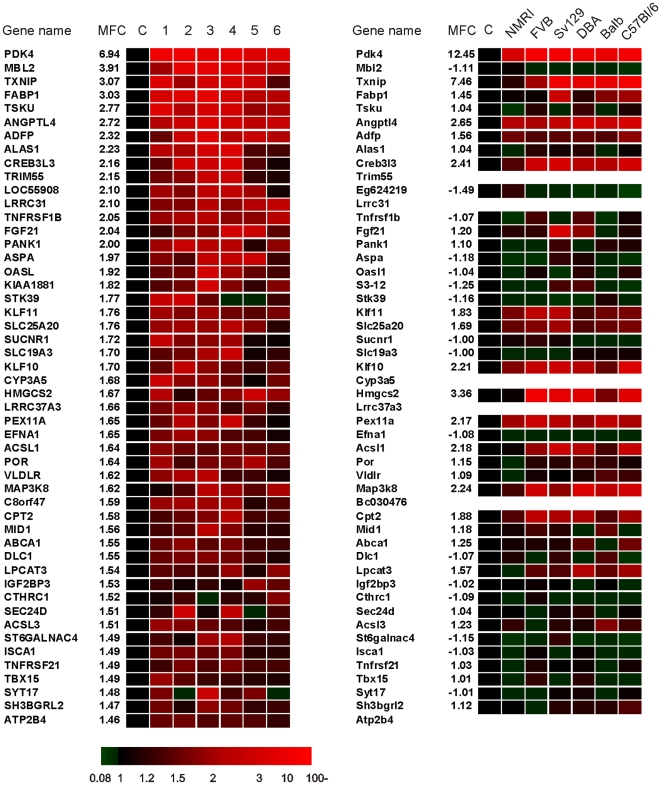
Partial conservation of Wy14643-induced gene regulation between human and mouse hepatocytes.Heat map illustrating the relative induction of the top 50 of upregulated genes in response to 6 h Wy14643 treatment in human hepatocytes. All genes were significantly changed (P<0.05) and were ranked based on mean fold-change (MFC). Expression levels in the DMSO-treated cells were set at 1. Relative changes in expression of the corresponding mouse orthologs in mouse hepatocytes are shown in parallel.